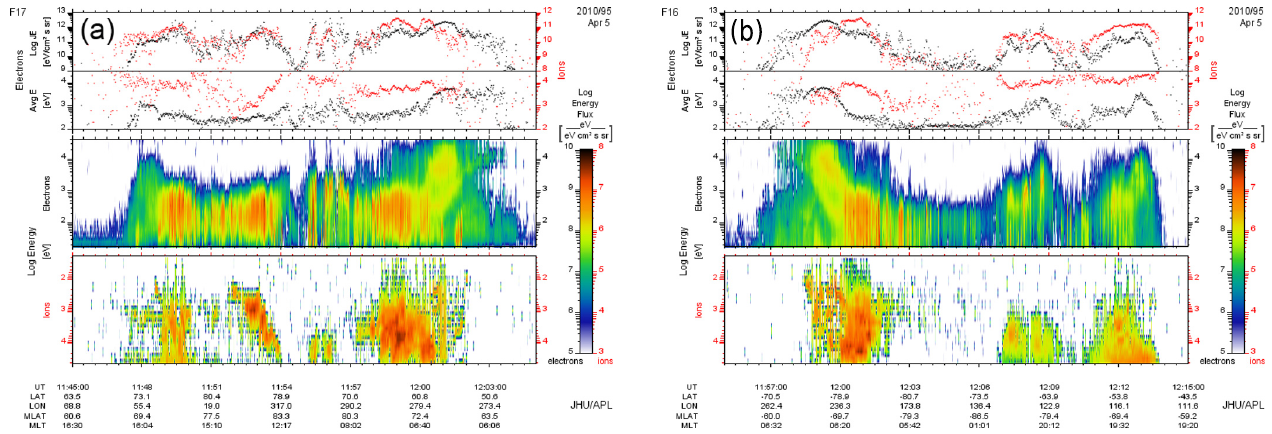
Fig. 11. Precipitating particle fluxes observed by DMSP satellites during passes over the (a) northern and (b) southern auroral ovals and polar caps. The F17 and F16 satellites passed nearest to Eureka and Concordia at ∼ 11:55UT and 12:06UT, respectively.